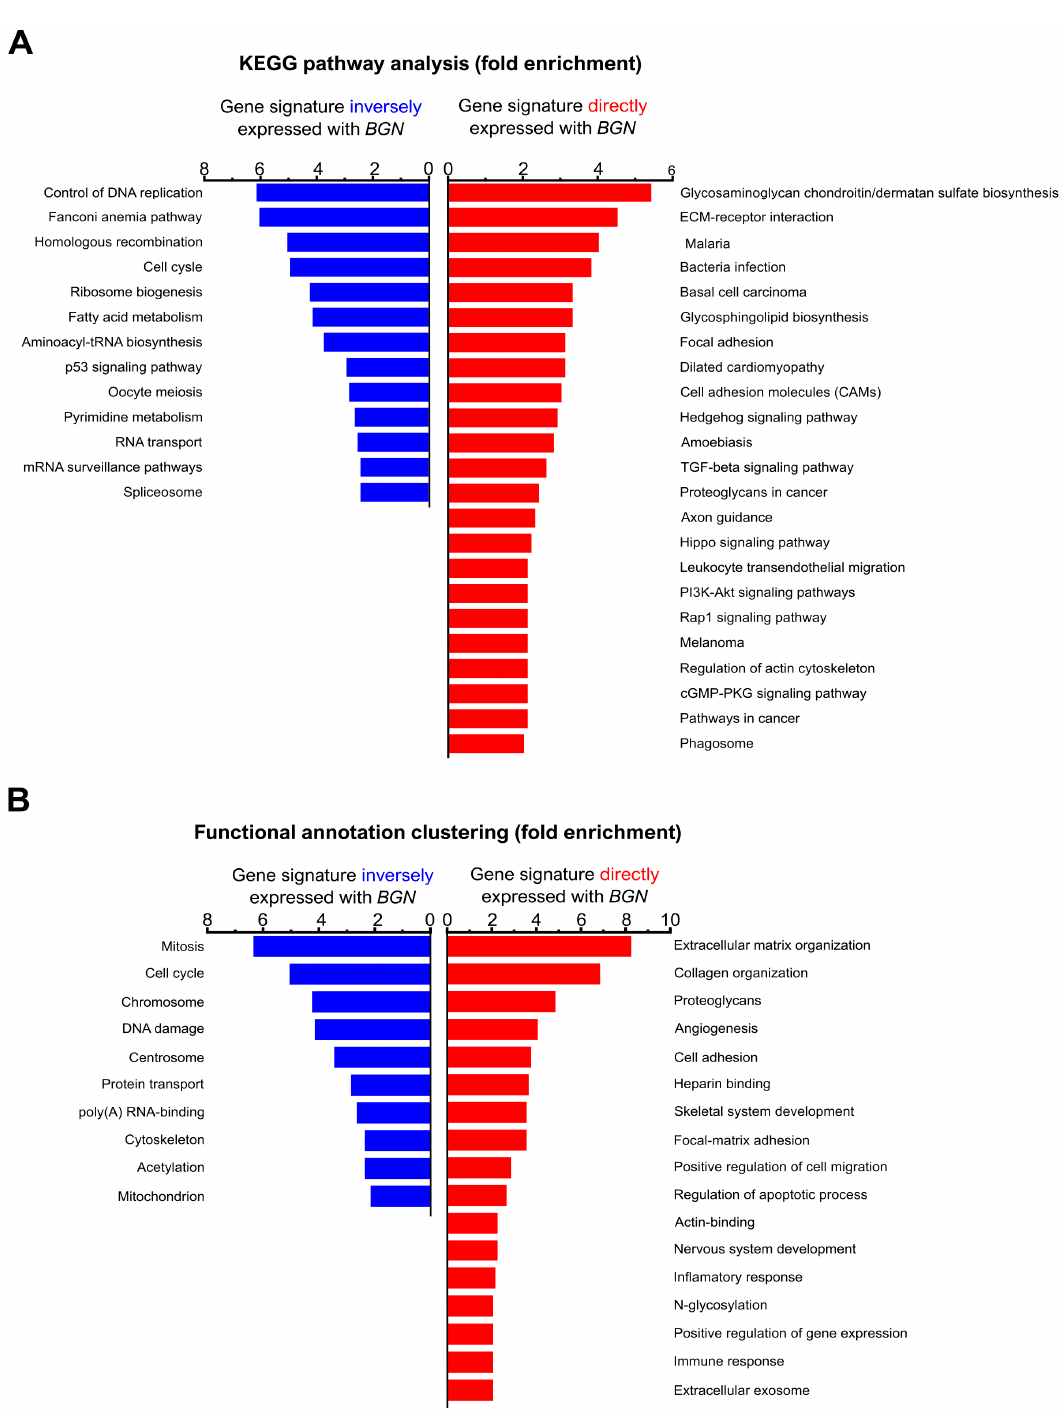
Figure 2. Functional analysis of BGN ( biglycan ) gene expression in clinical GC samples. ( A ) KEGG pathway analysis of genes profiles inversely expressed with BGN (blue) or directly coexpressed with BGN (red). ( B ) Classification of BGN gene-associated profiles into functional processes using the DAVID classification system. A minimum two-fold threshold and a p value < 0.05 was considered.